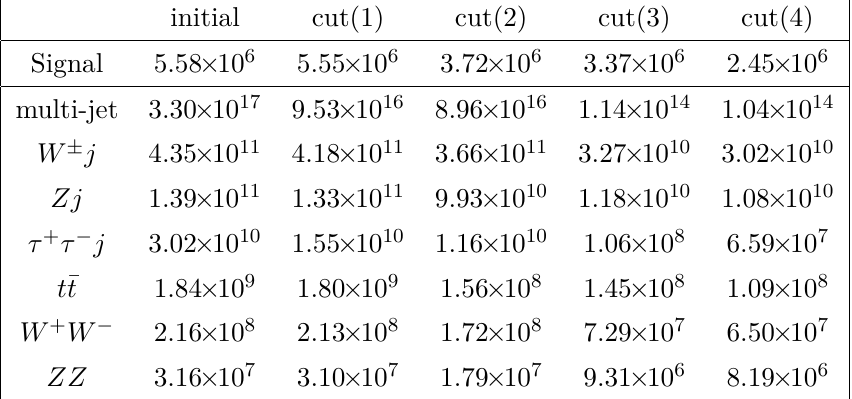
Table 1 . The expected number of events for the signal (with benchmark mass m a = 500 GeV and coupling C ˜ /f a = 10 − 2 TeV − 1 ) and relevant SM background processes after applying pre- G selection cuts (1)-(4) sequentially at the HL-LHC with center-of-mass energy 14 TeV and integrated luminosity 3 ab − 1